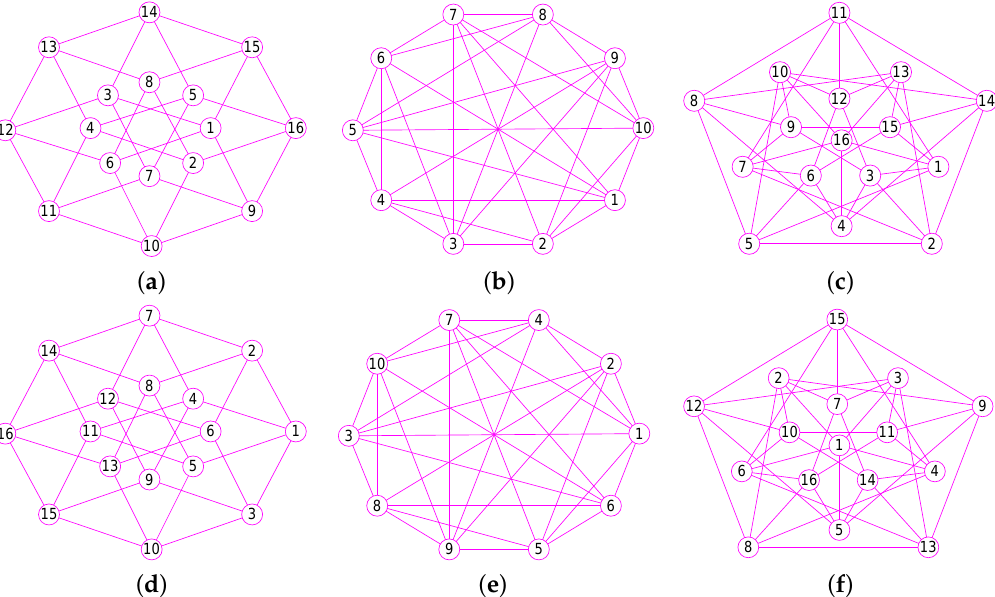
Figure 12. The TopMost graphs of three regular graphs G 8 , G 9 and G 10 . ( a ) The 4-hypercube graph G 8 of 16 vertices and 32 edges; ( b ) The triangular graph G 9 of 10 vertices and 30 edges; ( c ) The Clebsch graph G 10 of 16 vertices and 40 edges; ( d ) The TopMost graph of G 8 ; ( e ) The TopMost graph of G 9 ; ( f ) The TopMost graph of G 10